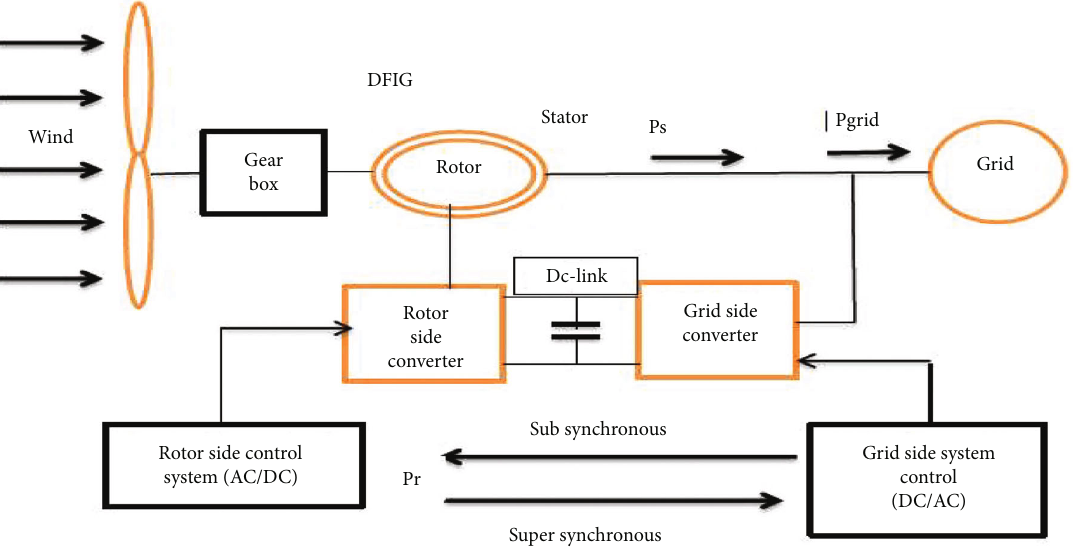
Figure 1: DFIG-based wind energy conversion system.